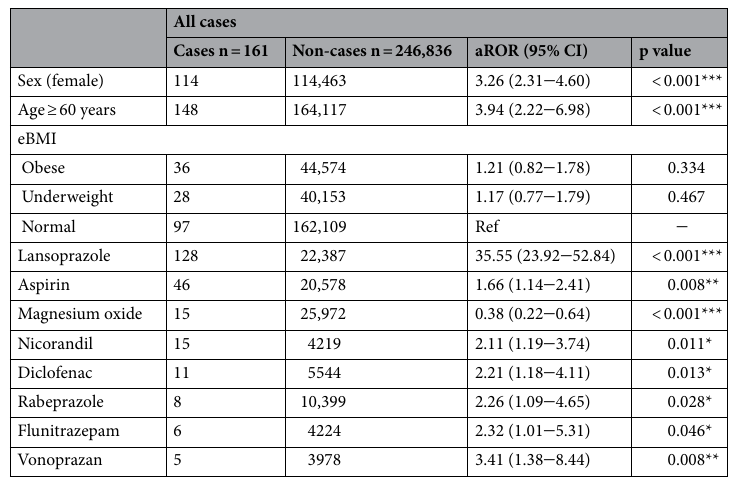
Table 2. Multiple logistic regression analysis of microscopic colitis using variables of drug and patient background in all cases. The adjusted reporting odds ratio (aROR) and 95% confidence intervals (95% CI) of microscopic colitis were calculated for sex, age, eBMI and each drug. eBMI estimated body mass index. ***p < 0.001, **p < 0.01, *p < 0.05, p: statistical significance obtained in multiple logistic regression analysis.